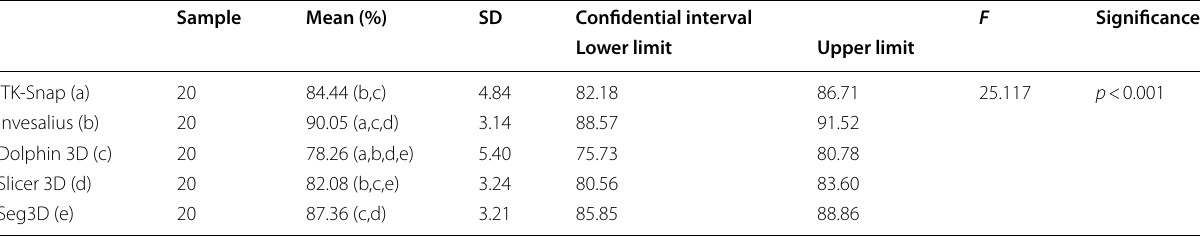
*Significance set at p < 0.05 and based on one-way analysis of variance (ANOVA) and Scheffe’s post-hoc comparisons tests; a, b, c, d, e comparisons tests